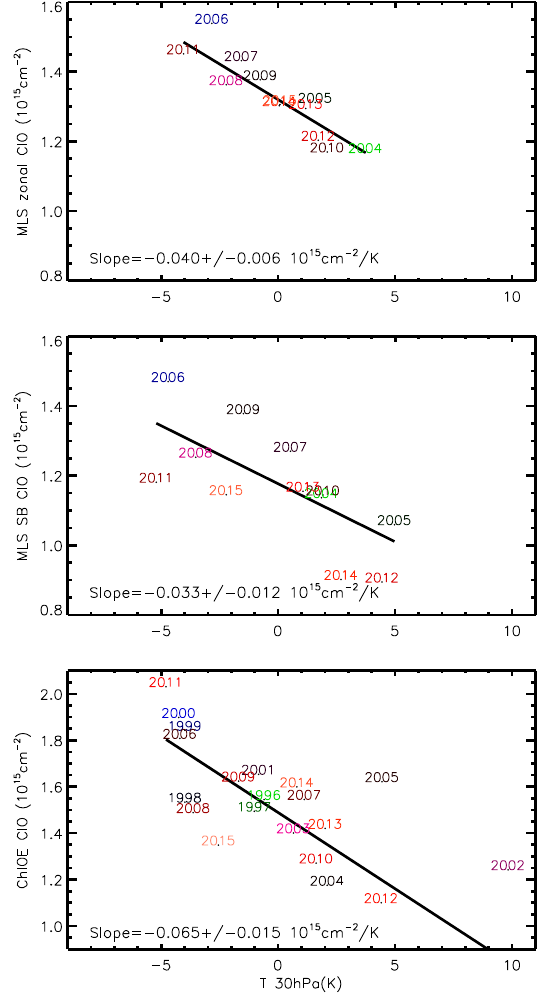
Figure 8. The climatology plus annual average anomaly for the 28 August to 17 September column ClO (shown in Fig. 5) plotted against the temperature anomalies (shown in Fig. 7). Also shown are linear fits with a 1 σ error estimate. Results are shown for the zon- ally average MLS ClO column measurements and 30hPa MERRA temperatures within ± 2 ◦ latitude of Scott Base (top), for MLS ClO and MERRA temperatures with a further restriction to within ± 15 ◦ longitude of Scott Base (middle), and for ChlOE ClO measurements and MERRA temperatures with this tighter restriction